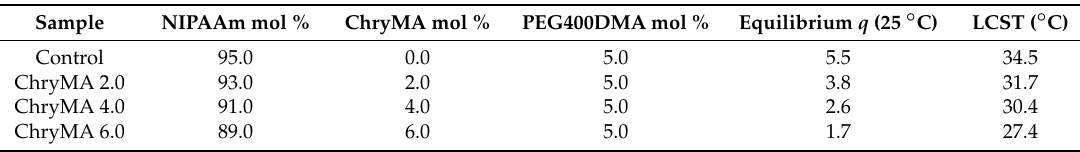
Table 1. The compositions, equilibrium swelling ratios, and LCSTs of the NIPAAm- co -ChryMA gels